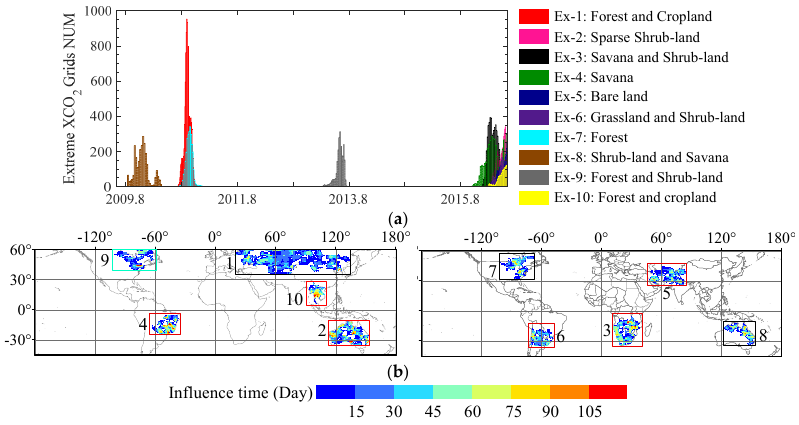
Figure 2. The duration ( a ) and spatial distribution ( b ) of the ten largest extreme events (Ex). Those occurring in 2009–2010 are outlined in black (Ex-1, Ex-7, Ex-8), 2013 is in blue (Ex-9) and 2015–2016 are in red (Ex-2, Ex-3, Ex-4, Ex-5, Ex-6, Ex-10). The main land-cover type over the ten selected extreme units was based on MCD12C1 in 2009 from the Moderate Resolution Imaging Spectroradiometer (MODIS). ( a ) Influenced duration of largest 10 extreme high XCO 2 units; ( b ) Largest 10 extreme high XCO 2 units with influenced grids in space.